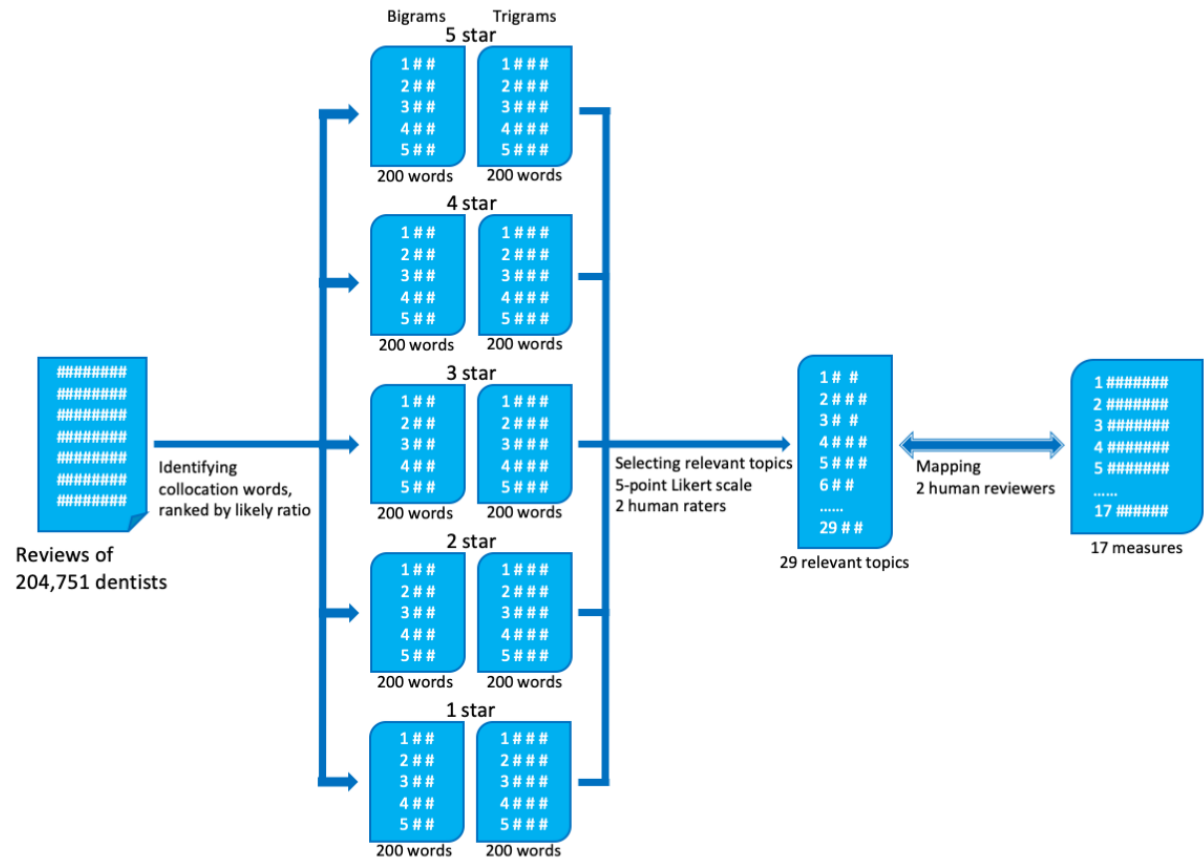
Figure 1. Diagram of text mining